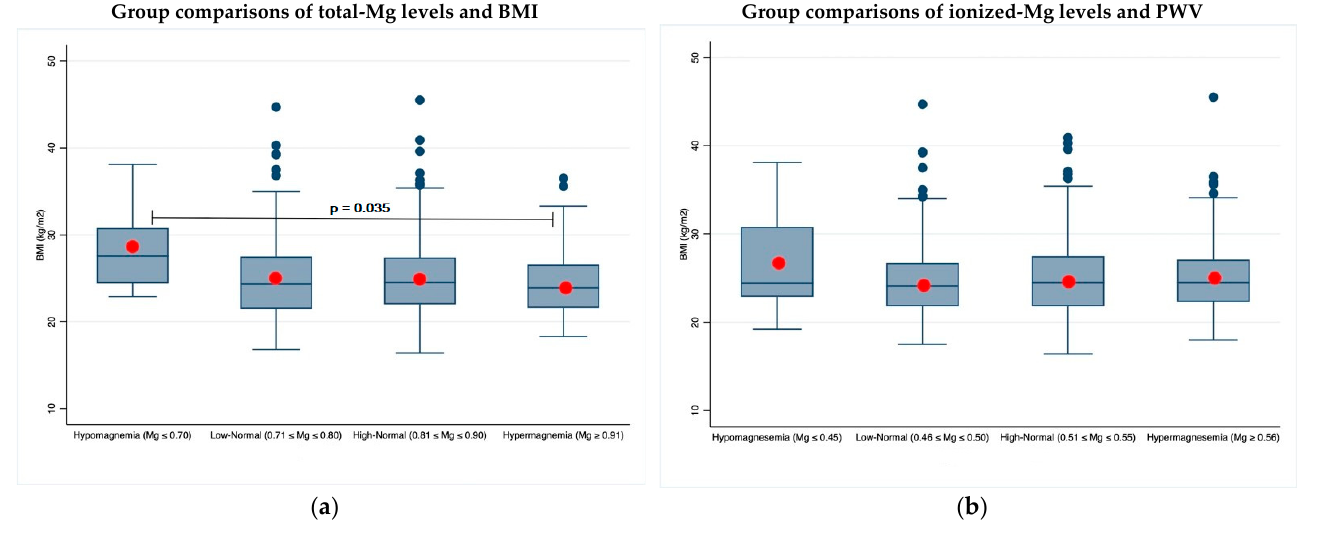
Figure 4. Two-by-two group comparisons of total and ionized magnesium levels and BMI: ( a ) BMI and tot-Mg; ( b ) BMI and ion-Mg. In the box plots, red circles indicate mean values, while blue lines indicate median values. Significant p -values between unadjusted mean values are superimposed on the graphs.